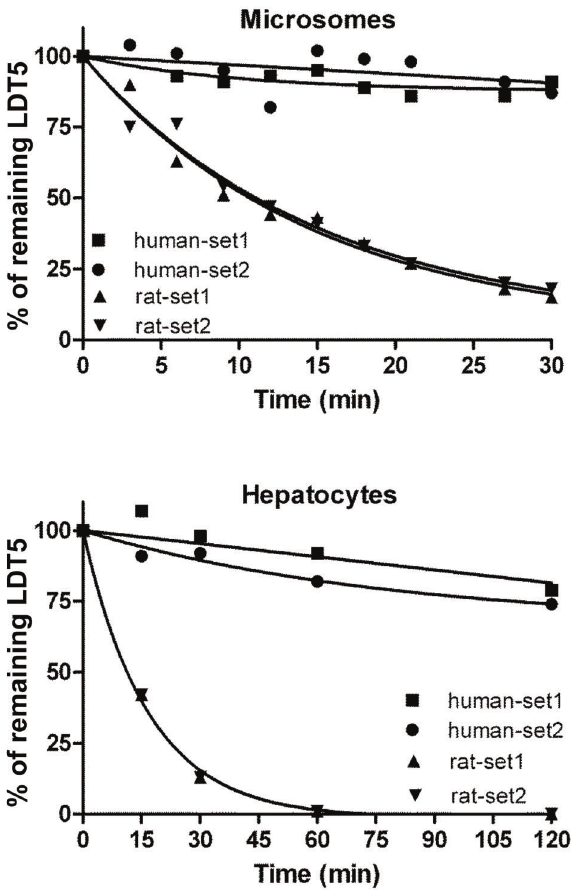
Figure 2. Time-dependent loss of LDT5 in rat and human liver microsomes ( top ) and in rat and human hepatocytes ( bottom ). LDT5 (0.5 m M) was incubated in the presence of liver microsomes (0.5 mg/mL) or hepatocytes (1 million cells/mL). Individual val- ues were obtained from two separate experiments. The fi tted curves were obtained by nonlinear regression analysis using the fi rst order decay